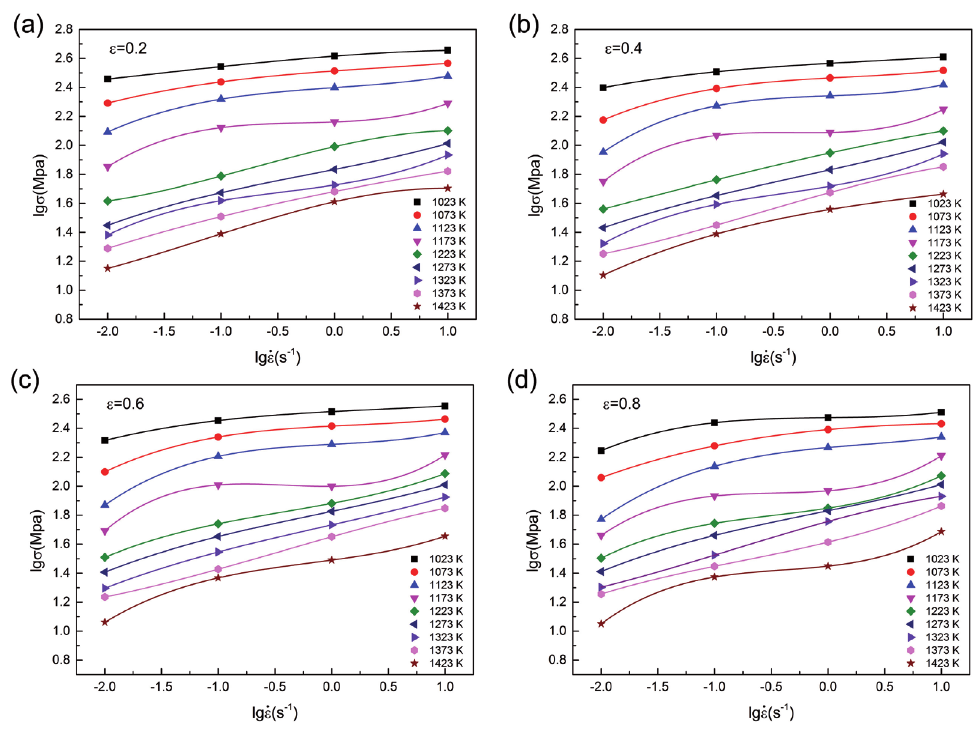
Figure 6: The relationships between stress and strain rate in log scale at different deforming temperatures and true strains (a) ε=0.2, (b) ε=0.4, (c)ε=0.6 and